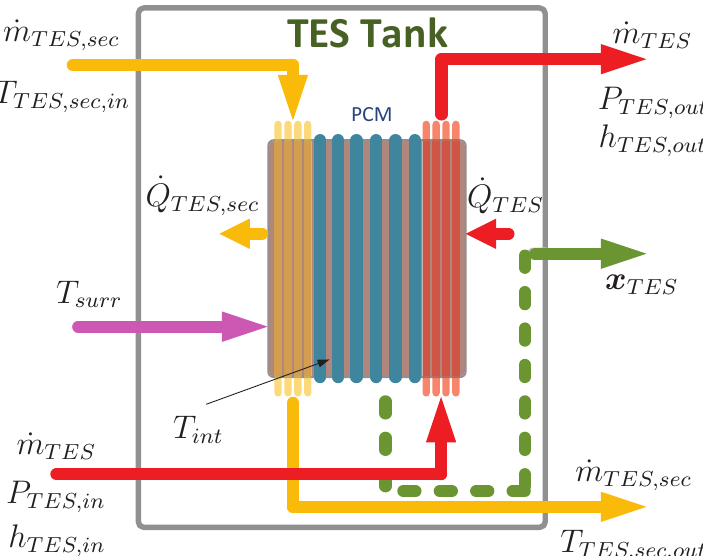
Figure 3. Configuration of the thermal energy storage tank. The physical and thermodynamic parameters of the TES tank are included in Table 2, while the thermodynamic properties of the PCM are shown in Table 3. The intermedi-